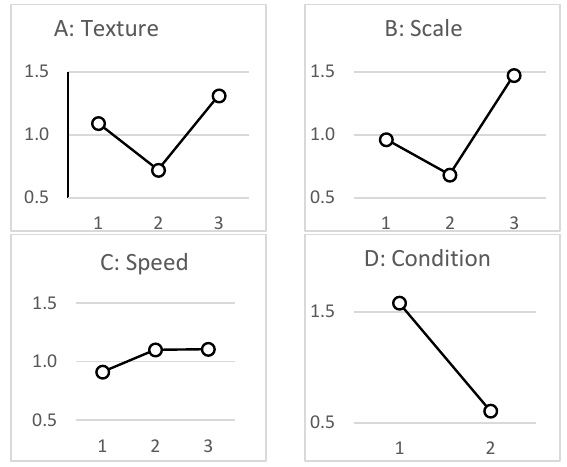
Figure 3. Factor level influence on  s.